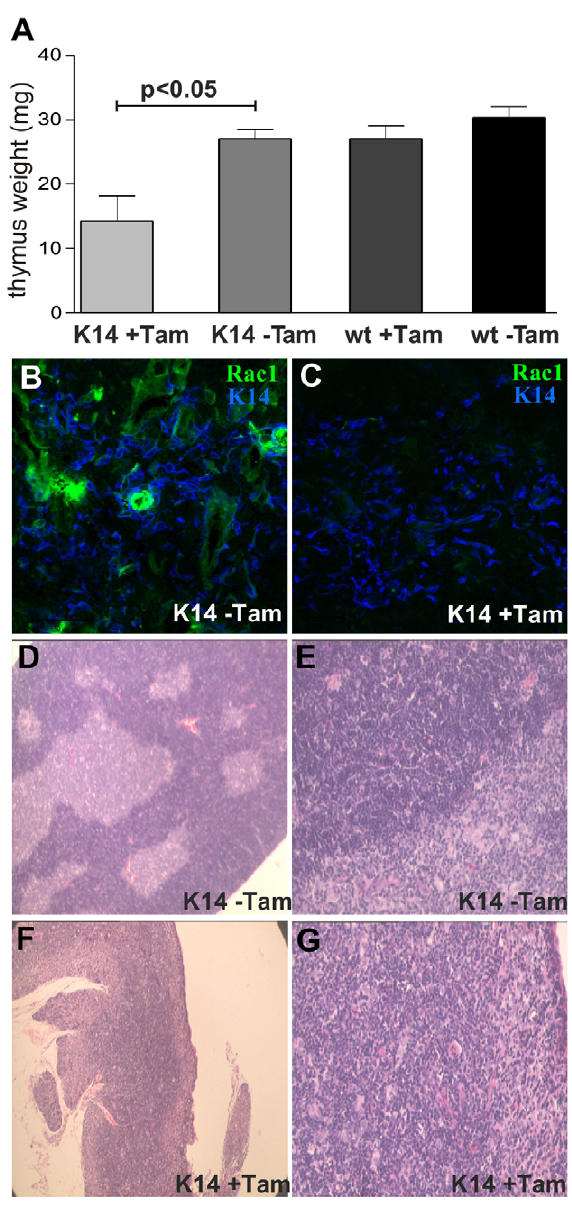
Figure 2. Effects of adult epithelial Rac1 deletion on thymus homeostasis and architecture. (A) Reduced weight of tamoxifen- treated K14CreERxRac1 flox/flox (K14 + Tam) compared to controls: no tamoxifen treated K14CreERxRac1 flox/flox (K14 2 Tam), tamoxifen treated and untreated no Cre litter mates (wt + Tam and wt 2 Tam respectively); p , 0.05).(BandC) Rac1immunofluorescencedemonstratingRac1deletion in the K14 + Tam (C) compared to untreated control (B). (D and E) Normal medullary-cortical architecture of untreated K14CreERxRac1 flox/flox mice (K14 2 Tam). (F and G) Loss of distinct medullary/cortical boundaries after three weeks in tamoxifen treated K14CreERxRac1 flox/flox mice (K14 + Tam). (B and D 6 4 and C and E 6 10).